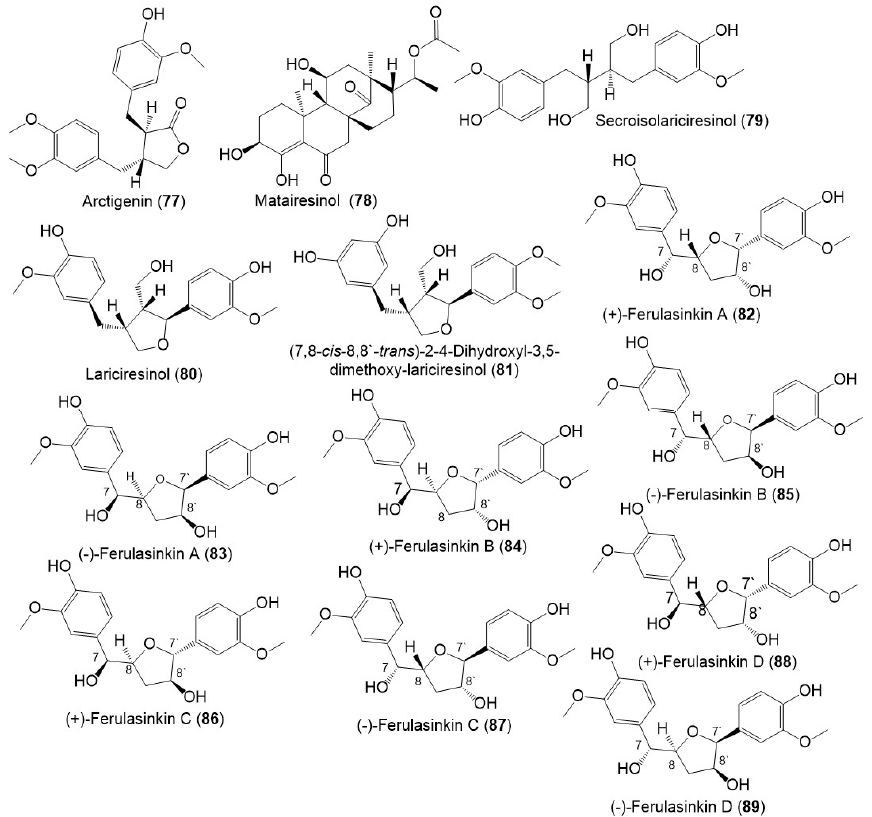
Figure 11. Structures of lignans ( 77 – 89 ) reported from F. sinkiangensis . The chiral column HPLC separation afforded their ( - )- and (+)-antipodes. Their struc- tures and configurations were specified by spectral tools and computational methods [28].